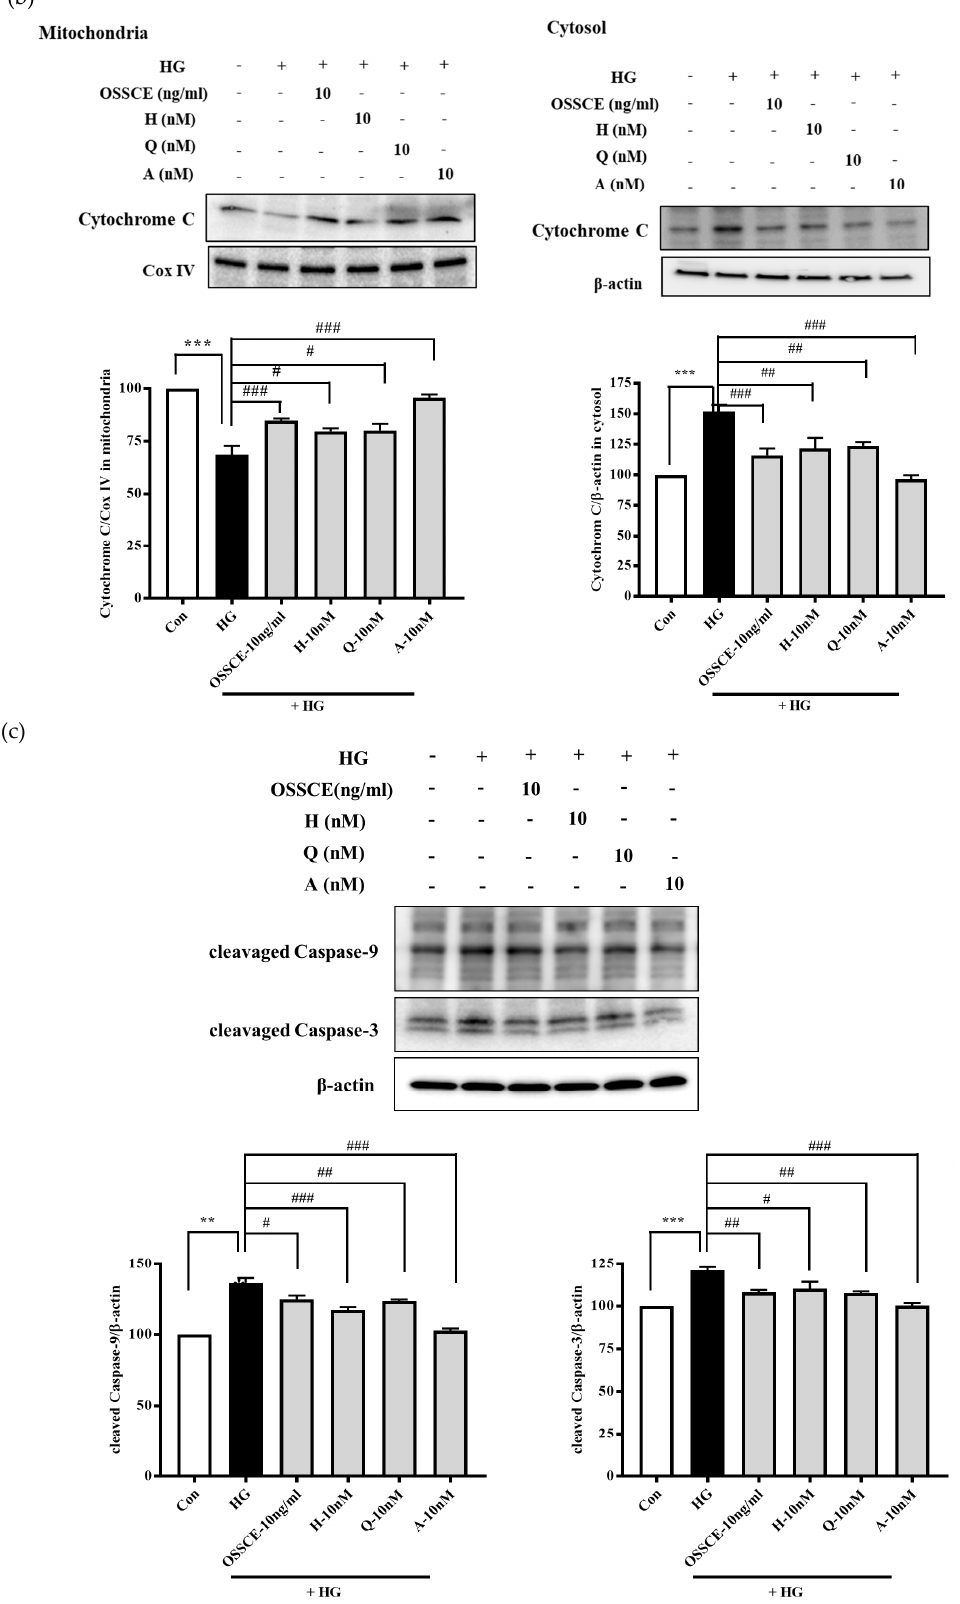
Figure 5. The effects of OSSCE and MCs on the mitochondria dependent-apoptotic pathways in HG-treated HRMECs: OSSCE and MCs restore the expression of Bax ( a ), cytochrome C ( b ), and caspase-9 and -3 ( c ) abnormally changed in HG-treated HRMECs. ** p < 0.01, *** p < 0.001 vs. Con; # p < 0.05, ## p < 0.01, ### p < 0.001 vs. HG. The data are expressed as mean ± SD ( n = 3). 3.7. OSSCE Inhibits the Activation of Nuclear Factor Κ -B (NF- Κ b) in SDT Rat Retina and HG-Treated Hrmecs An electrophoretic mobility shift assay (EMSA) analysis of nuclear proteins revealed that OSSCE treatment at a dose of 250 mg/kg/day significantly reduced nuclear translocation and DNA-binding activity of NF- κ B ( ### p < 0.001), whereas vehicle-treated SDT rats resulted in increased NF- κ B translocation (*** p < 0.001) relative to levels in normal SD rats (Figure 6a). OSSCE and MCs treatment also prevented the nuclear translocation of NF- κ B in HG-treated HRMECs (Figure 6b). The visualization (Figure 6b, left panel) and qualitative analysis of the nuclear translocation (Figure 6b, right panel) of NF- κ B in HG-treated HRMECs was performed using a fluorescence microscopy and the Image J software respectively (*** p < 0.001). The nuclear NF-kB levels in OSSCE and MCs-treated groups of HRMECs were significantly lower than that of the HG- treated group ( ### p < 0.001). We checked whether OSSCE inhibited IKK activity. As shown in Figure 6c, OSSCE treatment at doses of 50 ng/mL and 100 ng/mL dose-dependently inhibited IKK activity in HRMECs (** p < 0.01, *** p < 0.001).